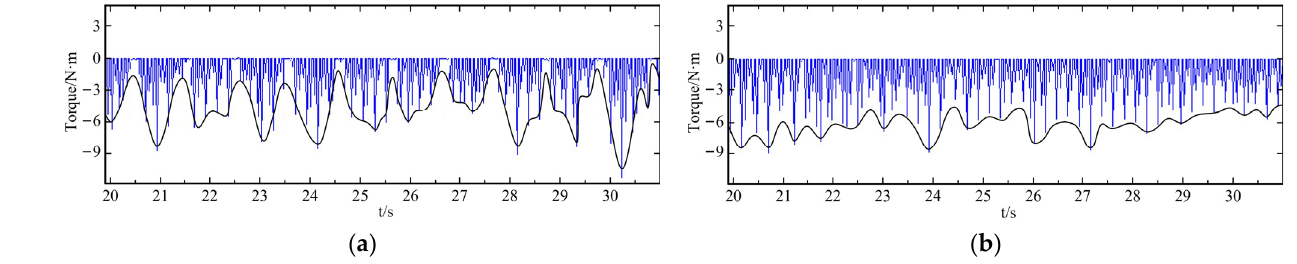
Figure 10. ( a ) The load torque waveform of the loading motor at a steady state from t = 20 s to t = 30 s, before the application of this method. ( b ) The load torque waveform of the loading motor at a steady state from t = 20 s to t = 30 s, after the application of this method.